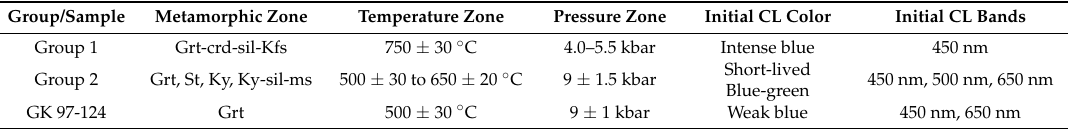
Table 2. Different CL groups with metamorphic zone, p-T conditions (data from [27]), initial CL bands and CL colors. Grt: garnet zone, St: staurolite zone, Ky: kyanite zone,